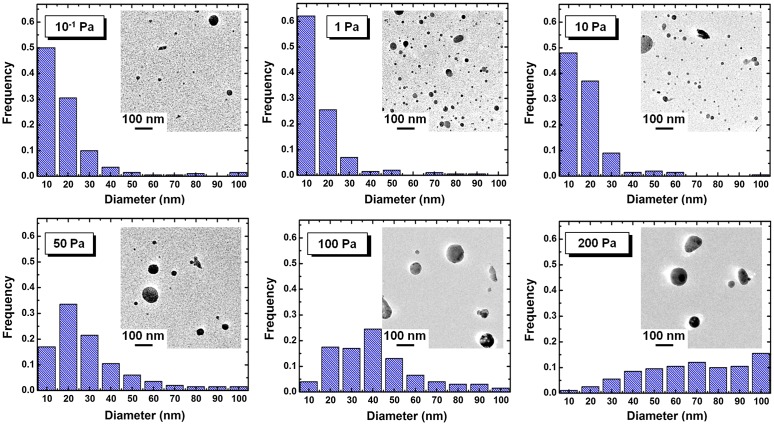
TEM images and size distributions of KMgF3 nanoparticles prepared under indicated gas pressure.